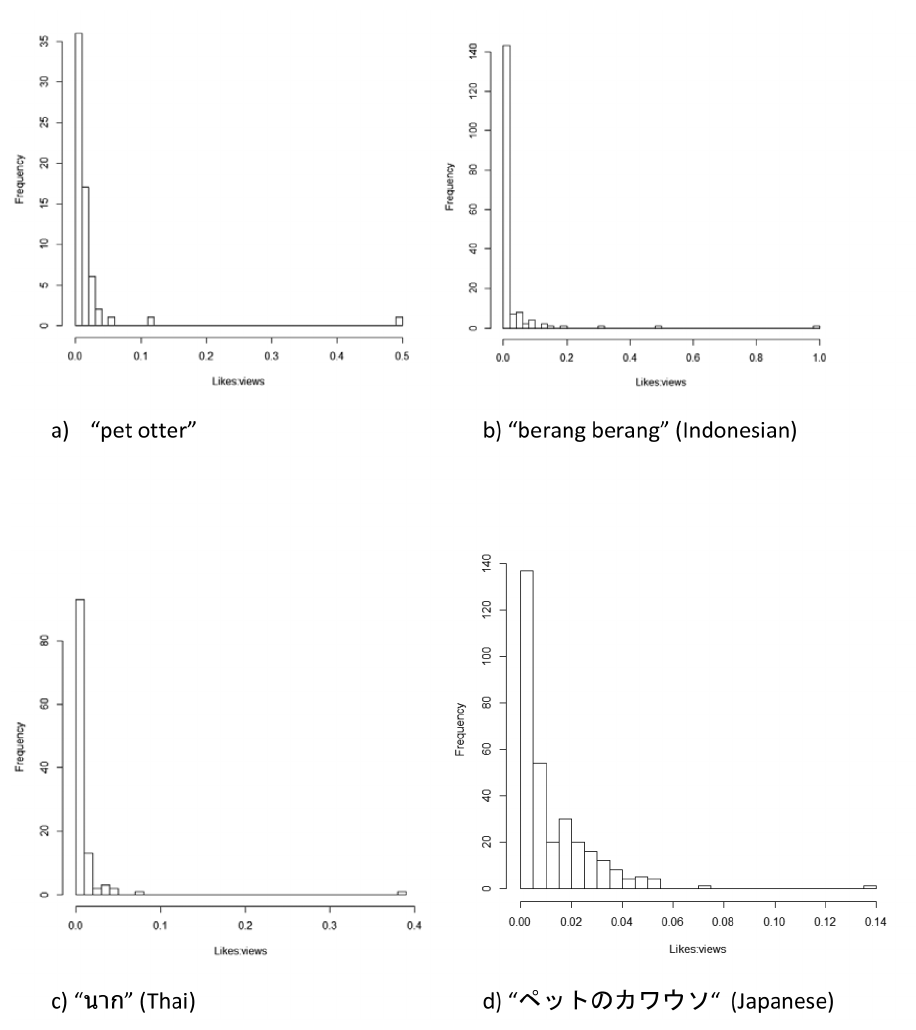
Figure A2. Like:view